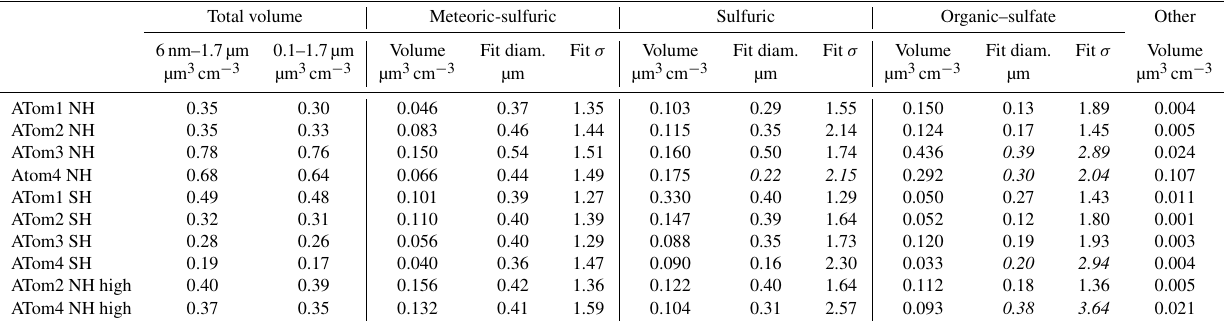
Table 1. Total volumes and volumes and lognormal fit parameters for individual types of particles. Lognormal fits were performed for particle volume, so the fit diameter is for the volume distribution. The volumes and fits are for the size range 0.1 to 1.7µm diameter except as noted (first column). Data are for 250–400ppbv ozone except the last two rows, the data of which are for 500–850ppbv. Volumes are per standard cubic centimeter. Fits are to the equation V = a · exp ( − ( ln D − ln D fit ) 2 /( 2 σ 2 )) , where D is the diameter and a is a scaling factor. Each fit is for a specific component. Fits were not attempted for “other” particles (mostly dust) because they did not generally show a defined mode. Italics indicate a poor fit to a single lognormal